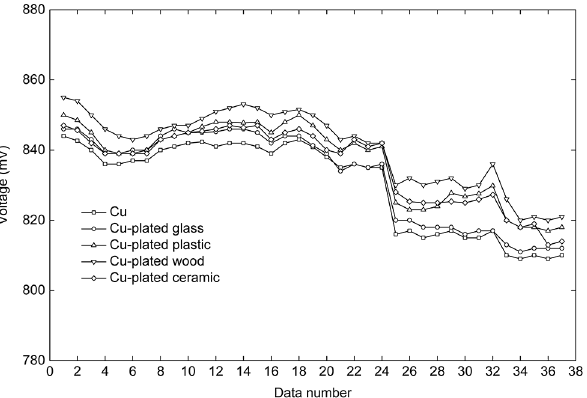
Fig 8. Voltage variations in the supplementary experiment. Five curves display the voltage variations measured with the five different electrodes. All curves follow the same trend. There is no obvious difference in amplitude among the